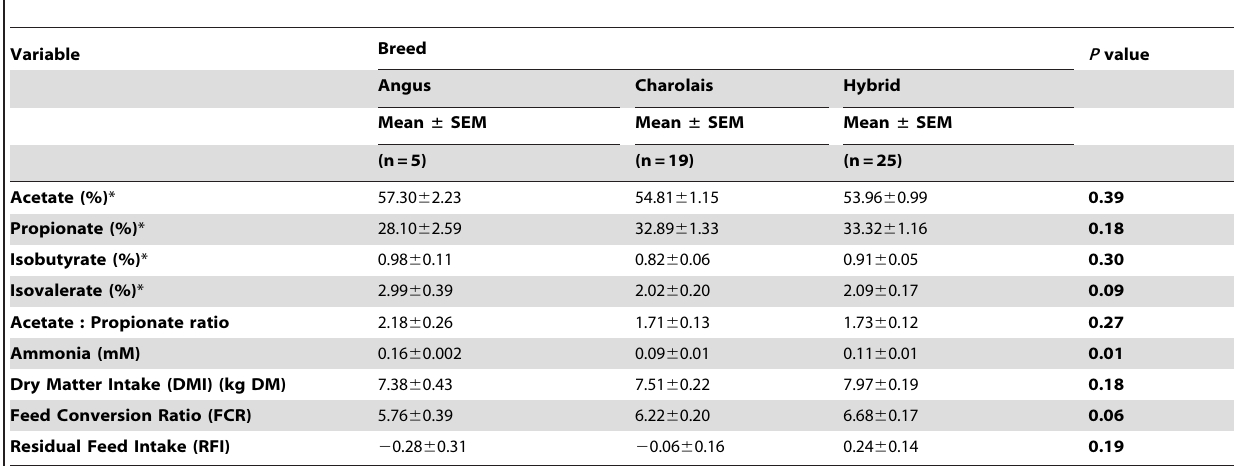
Table 5. Phenotypic indicators of metabolic differences (RFI, DMI and FCR) and ruminal metabolic measurements in steers differing breed (n=49) in LE.